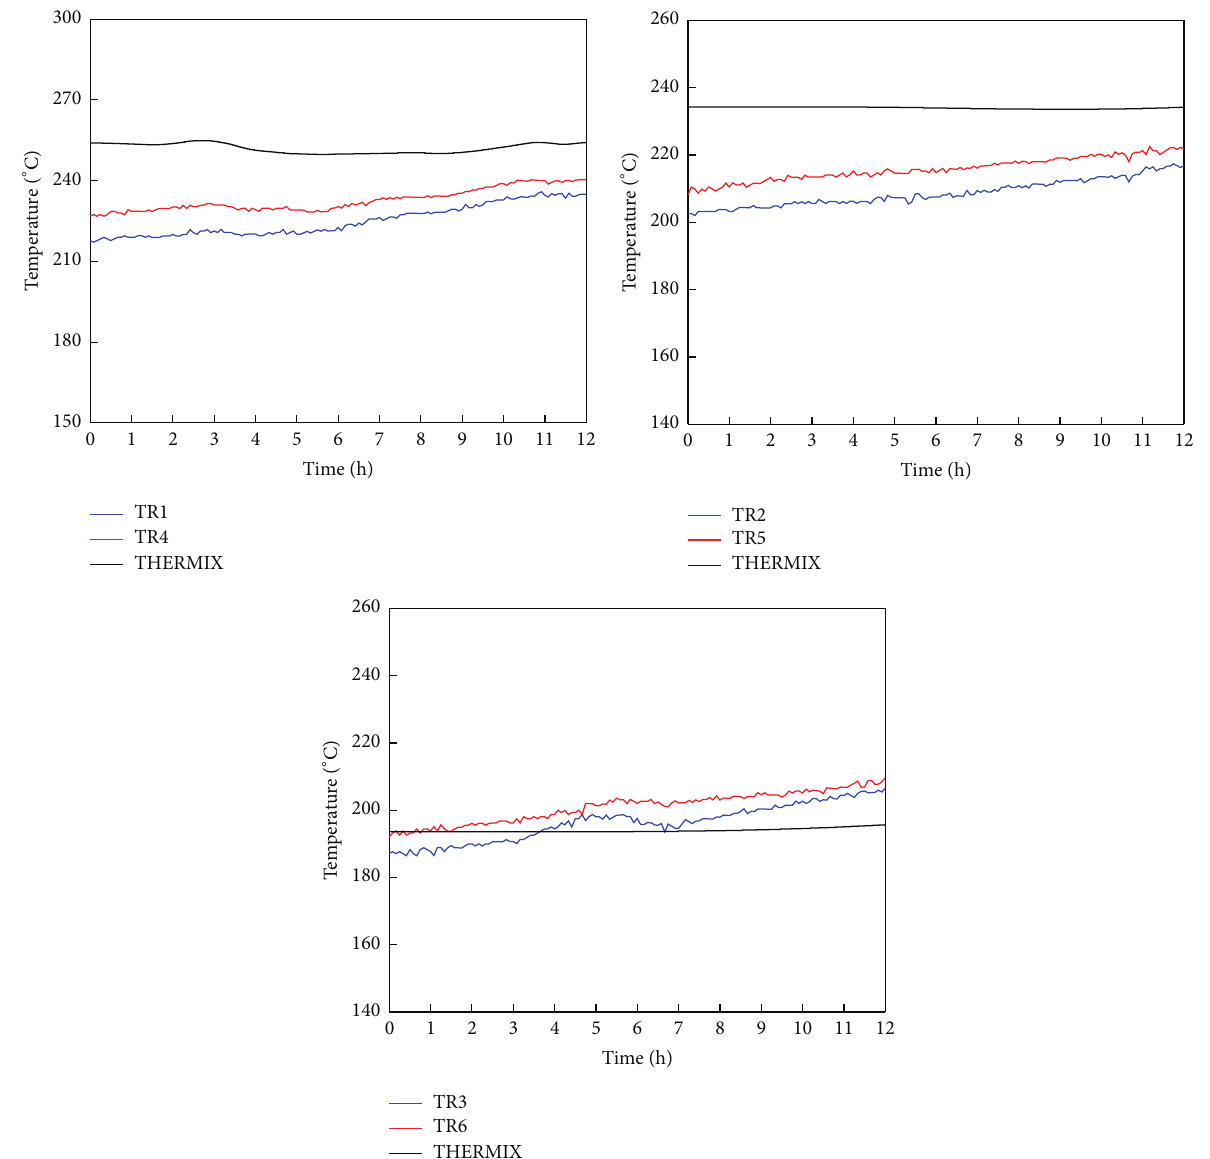
Figure 11: Temperature transient of the top